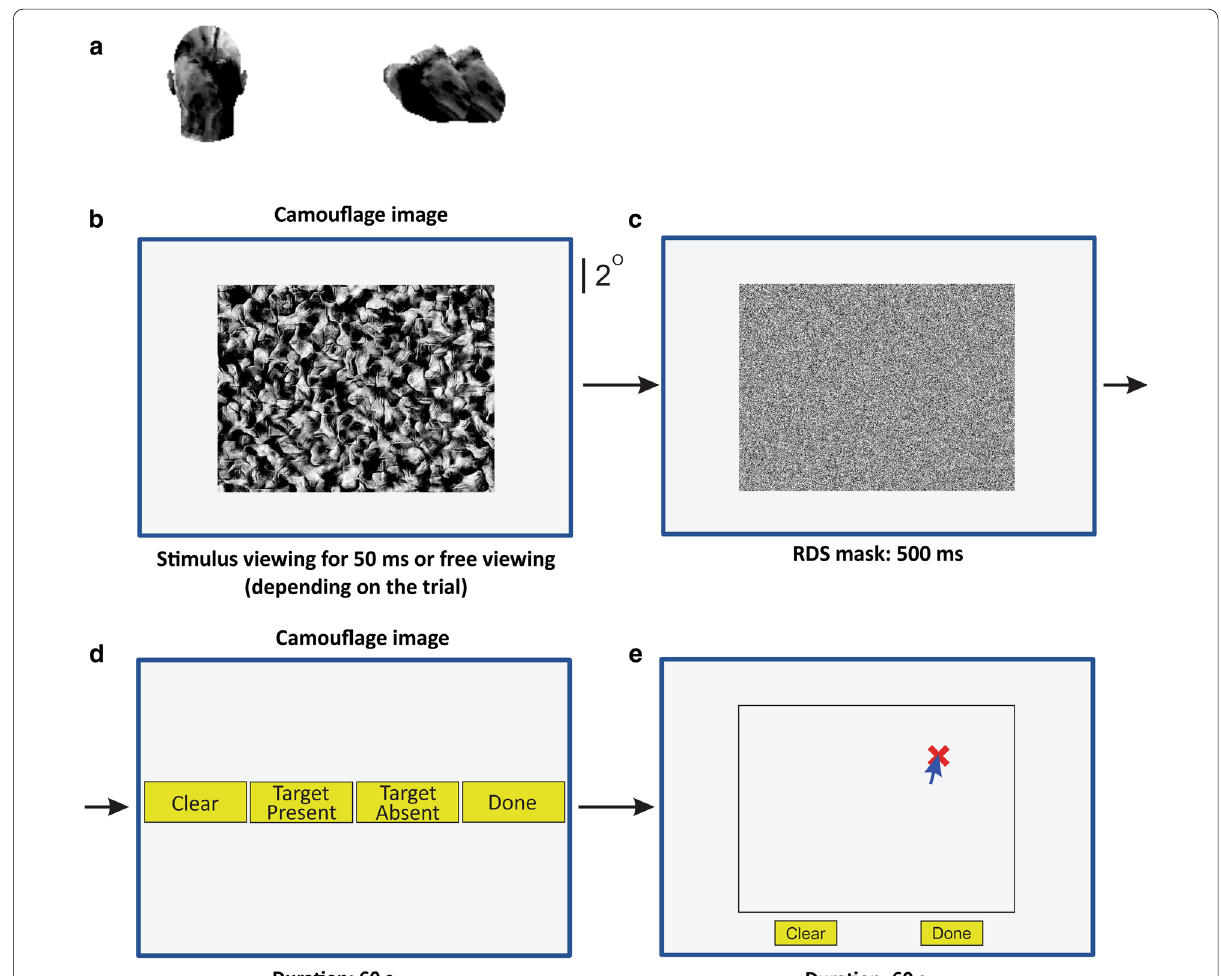
Fig. 1 Experiment 1: Visual search for camouflaged target. a Target objects. When a target was present, it was either a human head ( left ) or a digital embryo ( right ), each shown here at 4 their size in actual camouflage images. The human head target can be seen at the top right corner of the × camouflage image in panel B. b – e Task paradigm. Subjects viewed the camouflaged scene ( panel B ), followed by a 0.5 s random dot stimulus mask (RDS mask; panel C ). Subjects reported whether or not the preceding stimulus contained a target using designated onscreen buttons ( panel D ). Subjects were next presented with a blank outline of the image and were required to report the perceived location of the target (if the target was present) or the center of the image (if the target was absent) using a mouse click. An ‘X’ appeared at the clicked location ( panel E ). Not drawn to exact scale. See text for